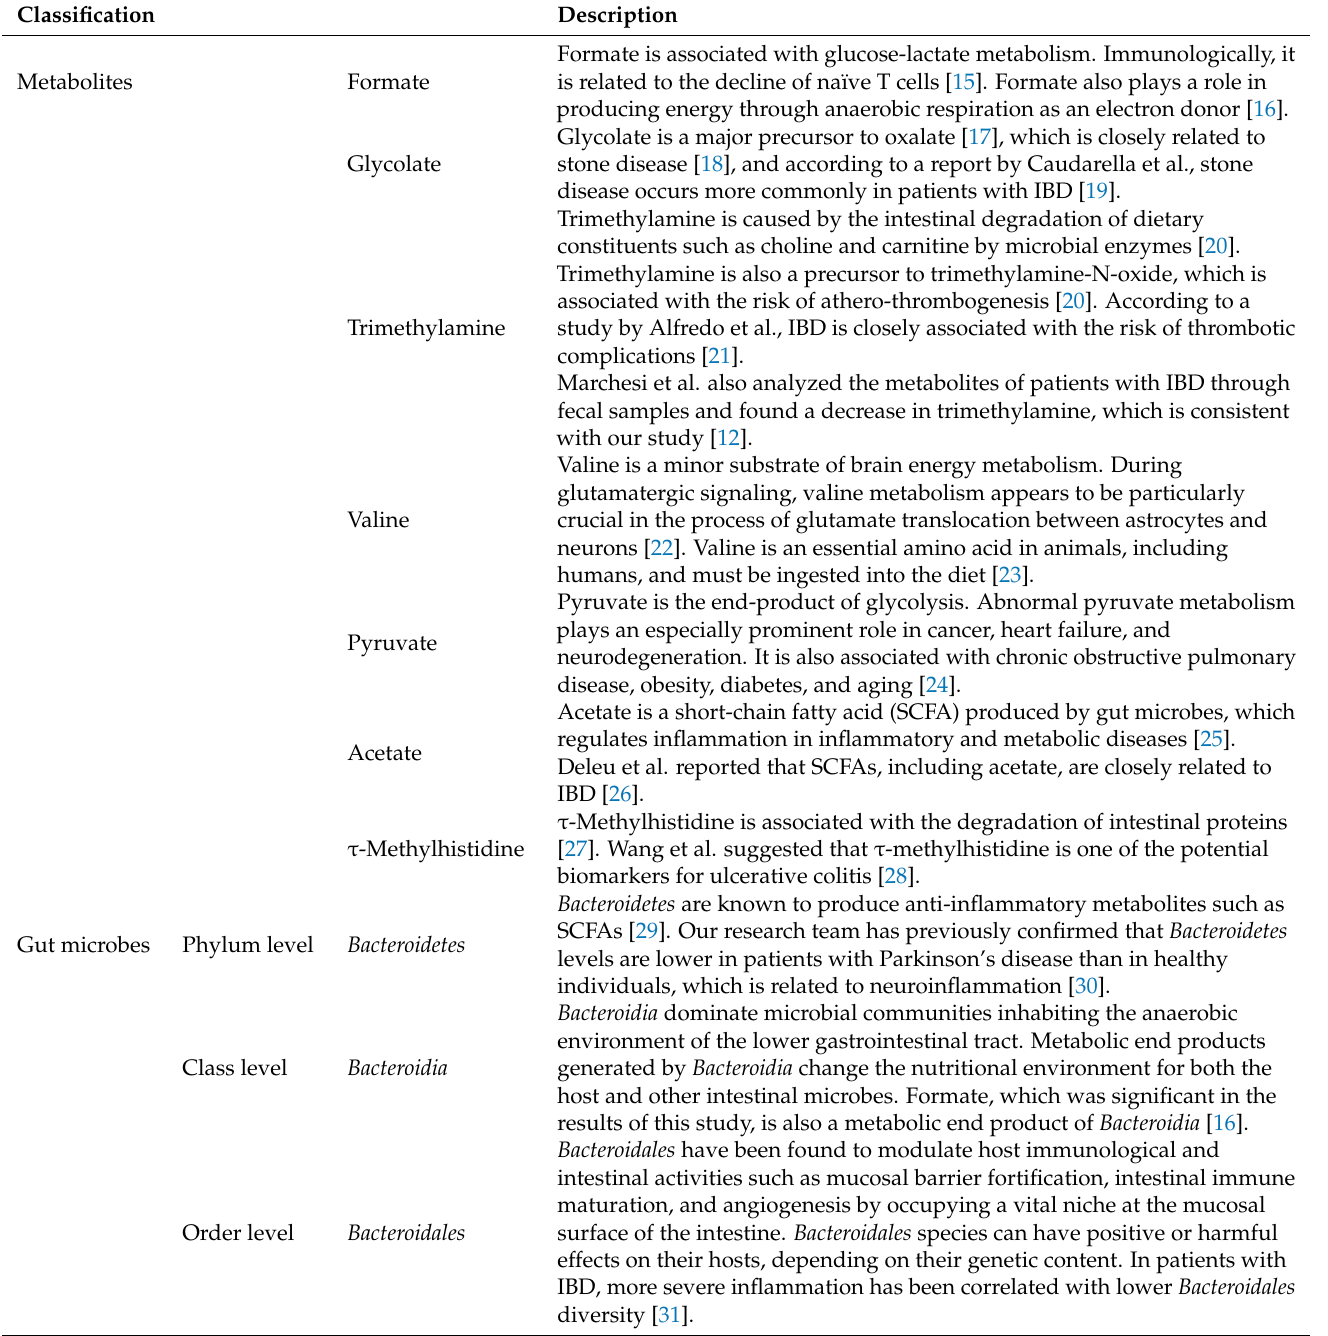
Table 3. Description of metabolites and gut microbes that significantly differed between UC and HC